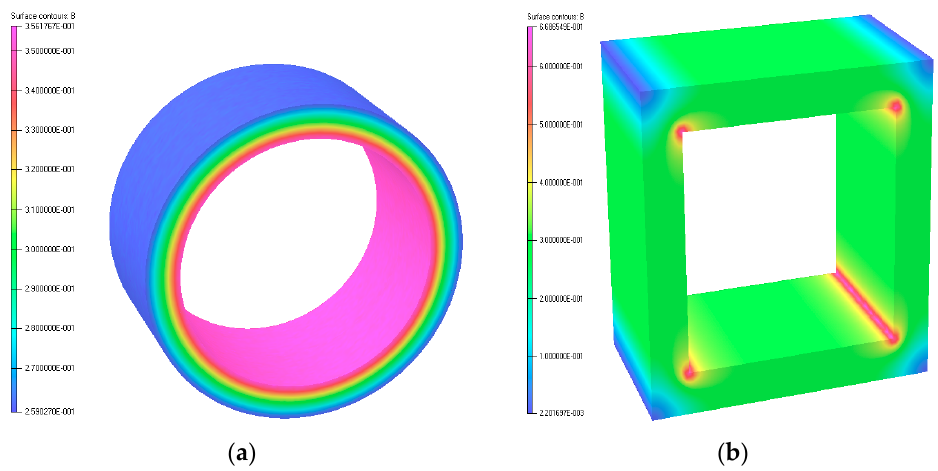
Figure 4. Magnetic flux density distributions (T) of measuring current transformers 600 A/5 A at the rated primary current 600 A for two core versions ( a ) toroid core, ( b ) split -core.